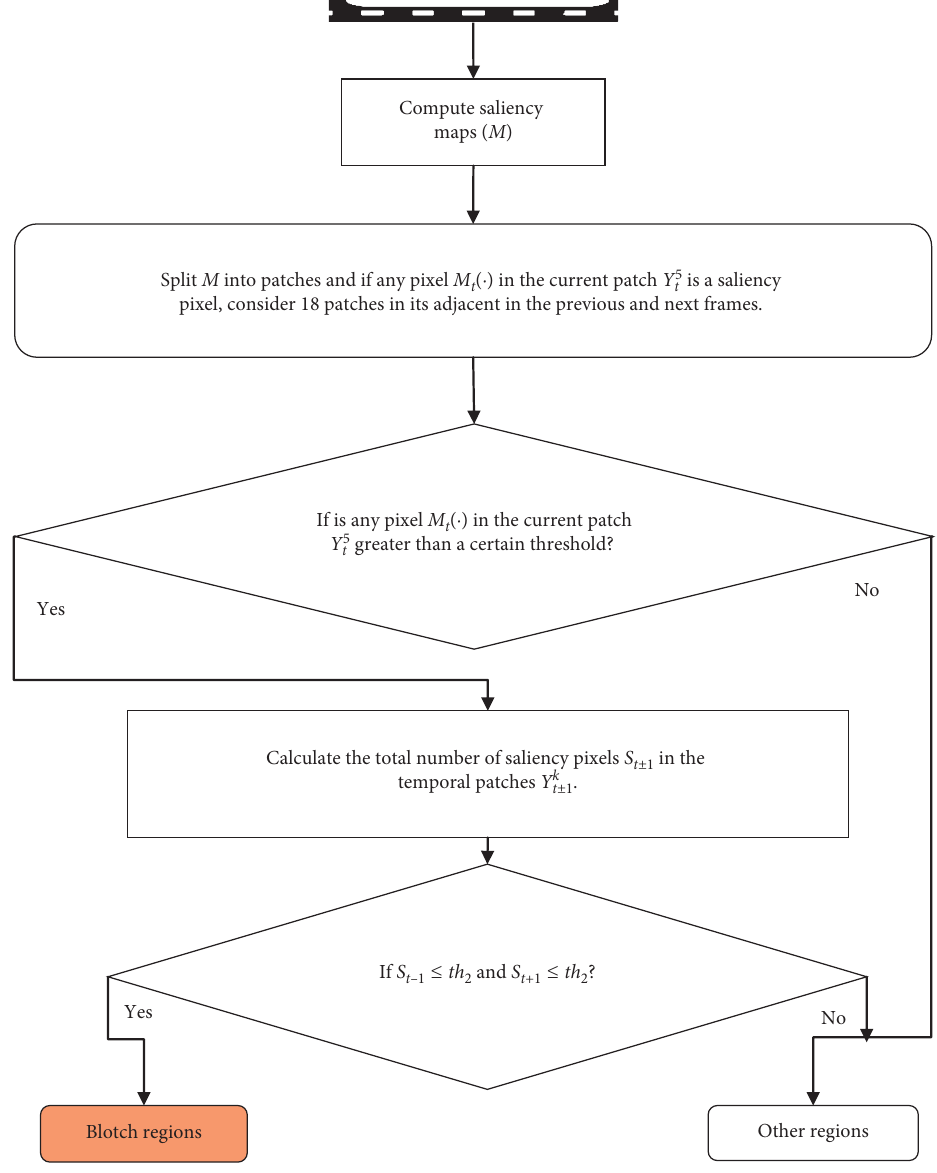
Figure 7: Flowchart of the proposed blotch detection